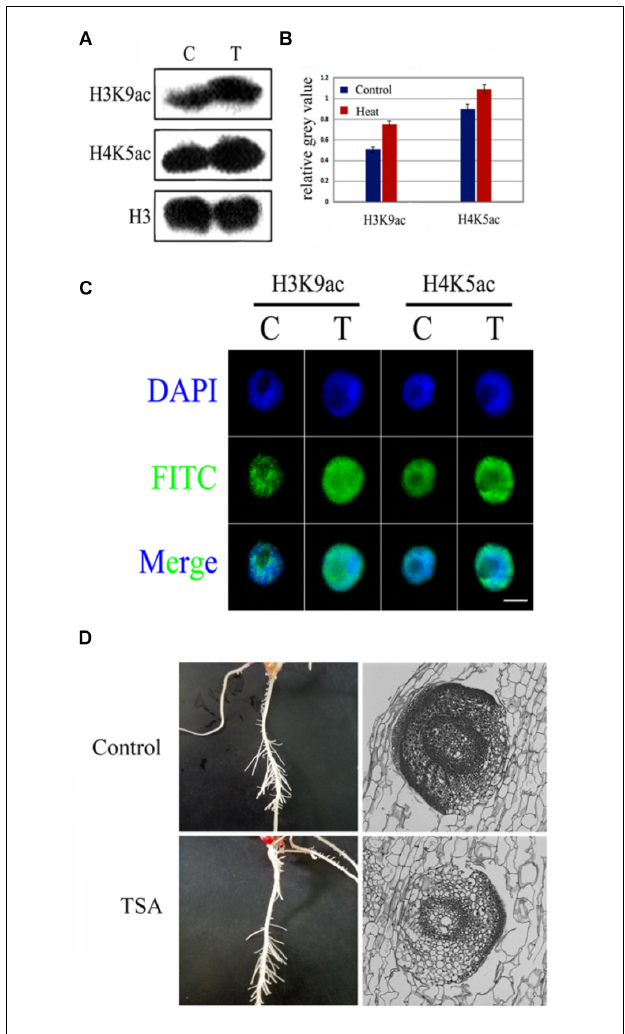
FIGURE 4 | TSA, an epigenetic inhibitor did not inhibit LRP initiation development in maize seedlings. (A,B) Western blot analysis showed that H3K9ac and H4K9ac levels in the maize seedlings was significantly increased after TSA treatment. (C) The nucleus was decondensed after TSA treatment. (D) Phenotype characteristics of maize plants under TSA treatment and control. TSA treatment did not inhibit the LRP initiation in maize, and the paraffin sections of the LRP in roots maize seedling at 3 days under TSA treatment. Western blot experiment is repeated three times. Five hundred nuclei were examined in each sample. Bar = 10 µ